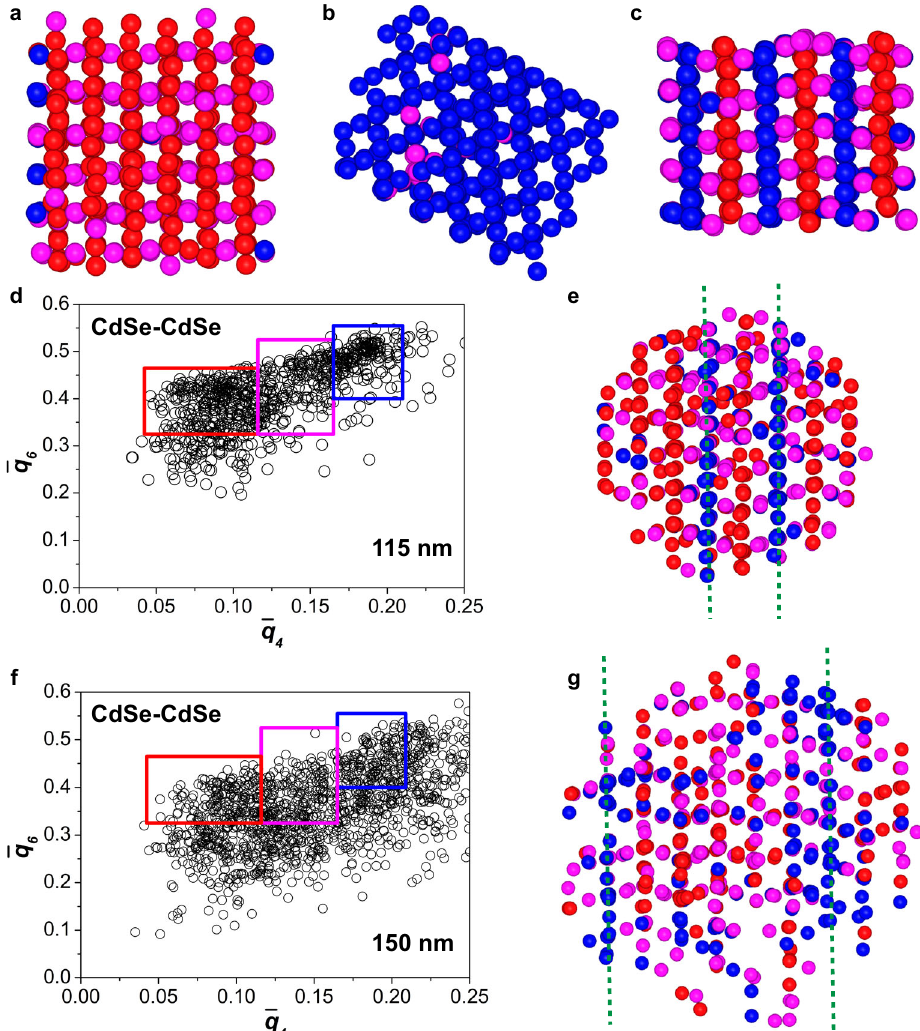
Fig. 5 BOP analysis of S species. Computer renderings of the S species (CdSe NCs) in the Laves phases ( a ) MgZn 2 , ( b ) MgCu 2 and ( c ) MgNi 2 , where the particles are colored according to their BOP values (Supplementary Fig. 14). Scatter plots of the BOPs of the S species in ( d ) 115 nm and f 150 nm-sized SPs, showing less well-de fi ned distributions compared with the L species (Fig. 4). Computer renderings of the S species with BOP values within the blue, magenta or red rectangles in ( e ) 115 nm and ( g ) 150 nm-sized SPs, revealing the stacking faults (marked with green dashed lines) in the crystal. Interactive 3D views ( a – c , e and g ) can be found in data Supplementary Data 11 –